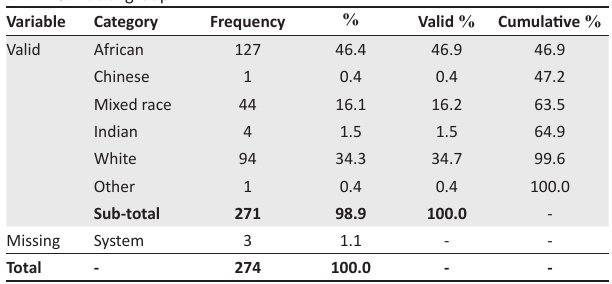
TABLE 5: Racial group. Variable